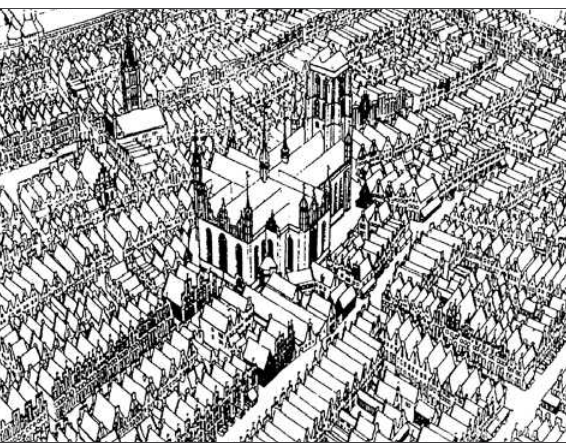
2 pav. Dansigas. Viduramžių miesto centro rekonstrukcija (iš kn. K. Gruber. Die Gestalt der deutschen Stadt. Munchen, 1983) Fig 2 . Dancing site. Reconstruction of medieval town centre